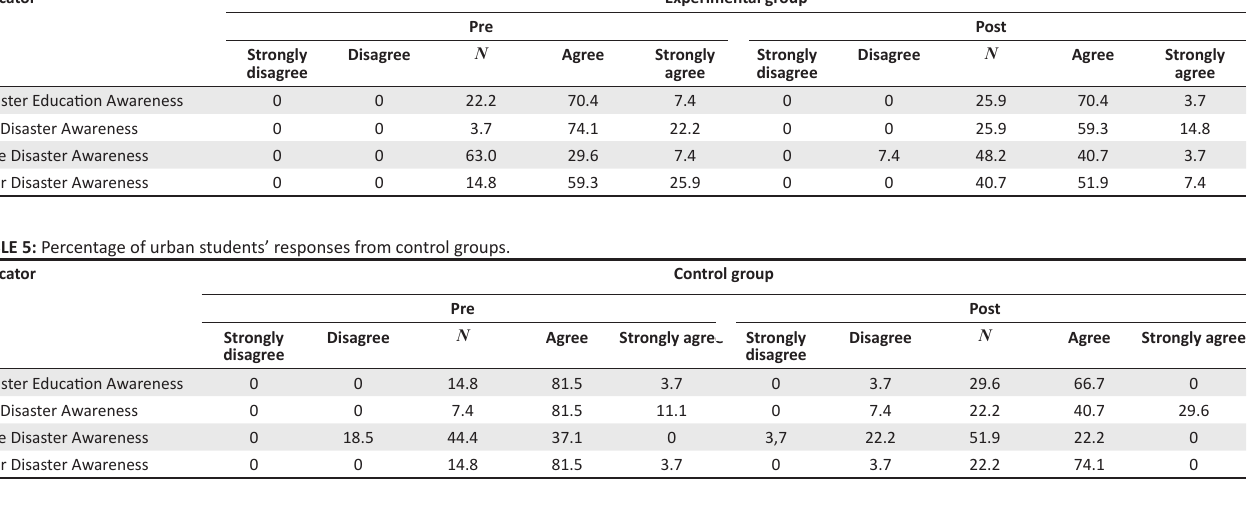
Maximum ideal score = 180. TABLE 4: Percentage of urban students’ responses from experimental groups. Indicator